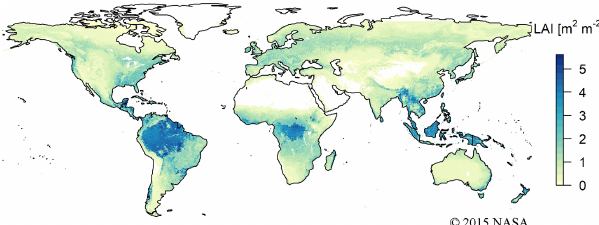
Figure 1. Global distribution of vegetation leaf area index (LAI). The mean LAI, at 5km resolution, is derived from the MODIS data product MCD15A3H.006 (Myneni et al.,